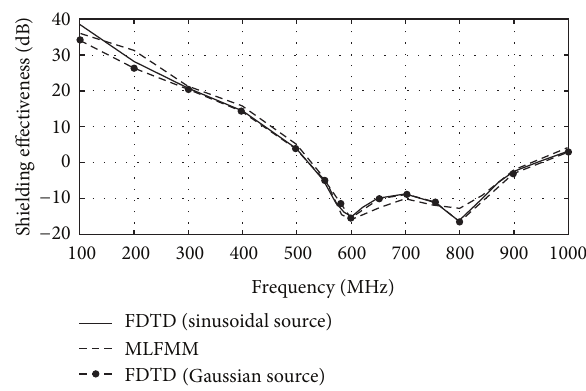
F 4: Comparison among the values of the SE obtained using threedifferentmethodsforabox-shapedenclosureofdimensions30 3cm with rectangular aperture of dimensions 30 12 30cm -polarized plane wave. 2 illuminated with 3 × × × 𝐸𝐸 𝑦𝑦